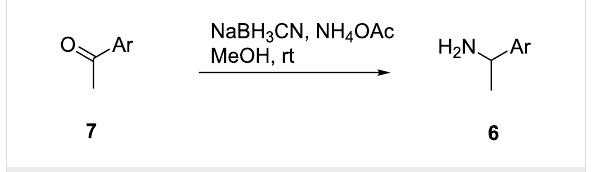
Scheme 3: Borch reductive amination of